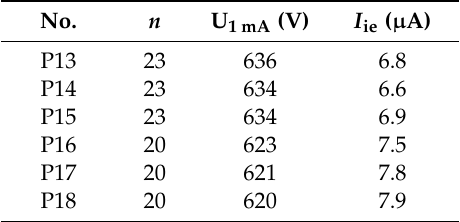
Table 4. The electrical parameters after the impulse with different number of pulses.